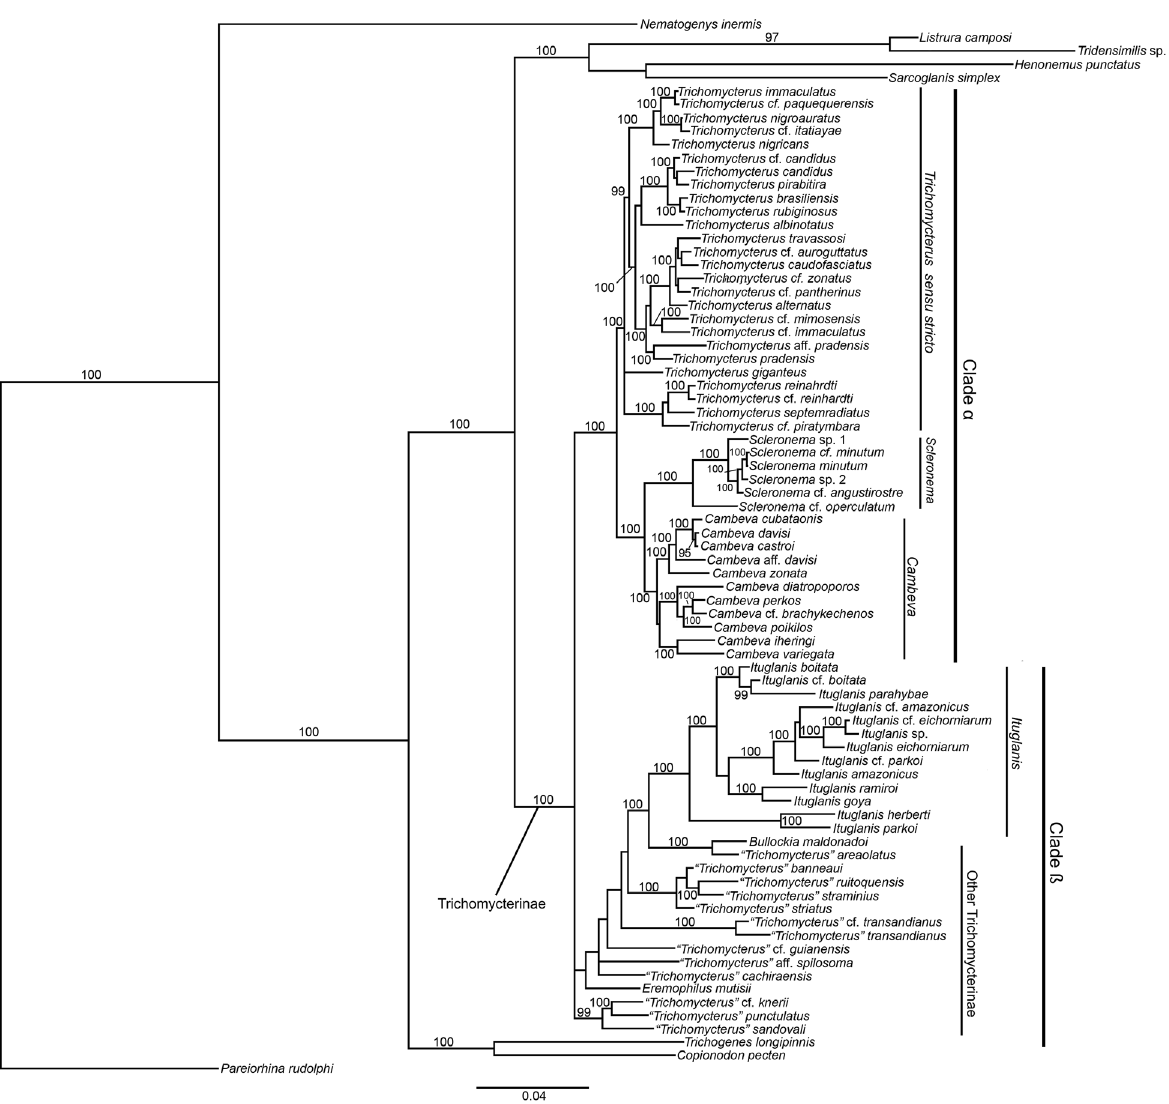
Figure 1. Phylogenetic positioning of Cambeva among the Trichomycteridae, inferred by Bayesian Inference from the analysis of molecular data, total of 4380 bp comprising segments of nuclear genes for GLYT, MYH6, RAG2 and SH3PX3 and the mitochon- drial genes COI and CYTB. Numbers on each node represent posterior